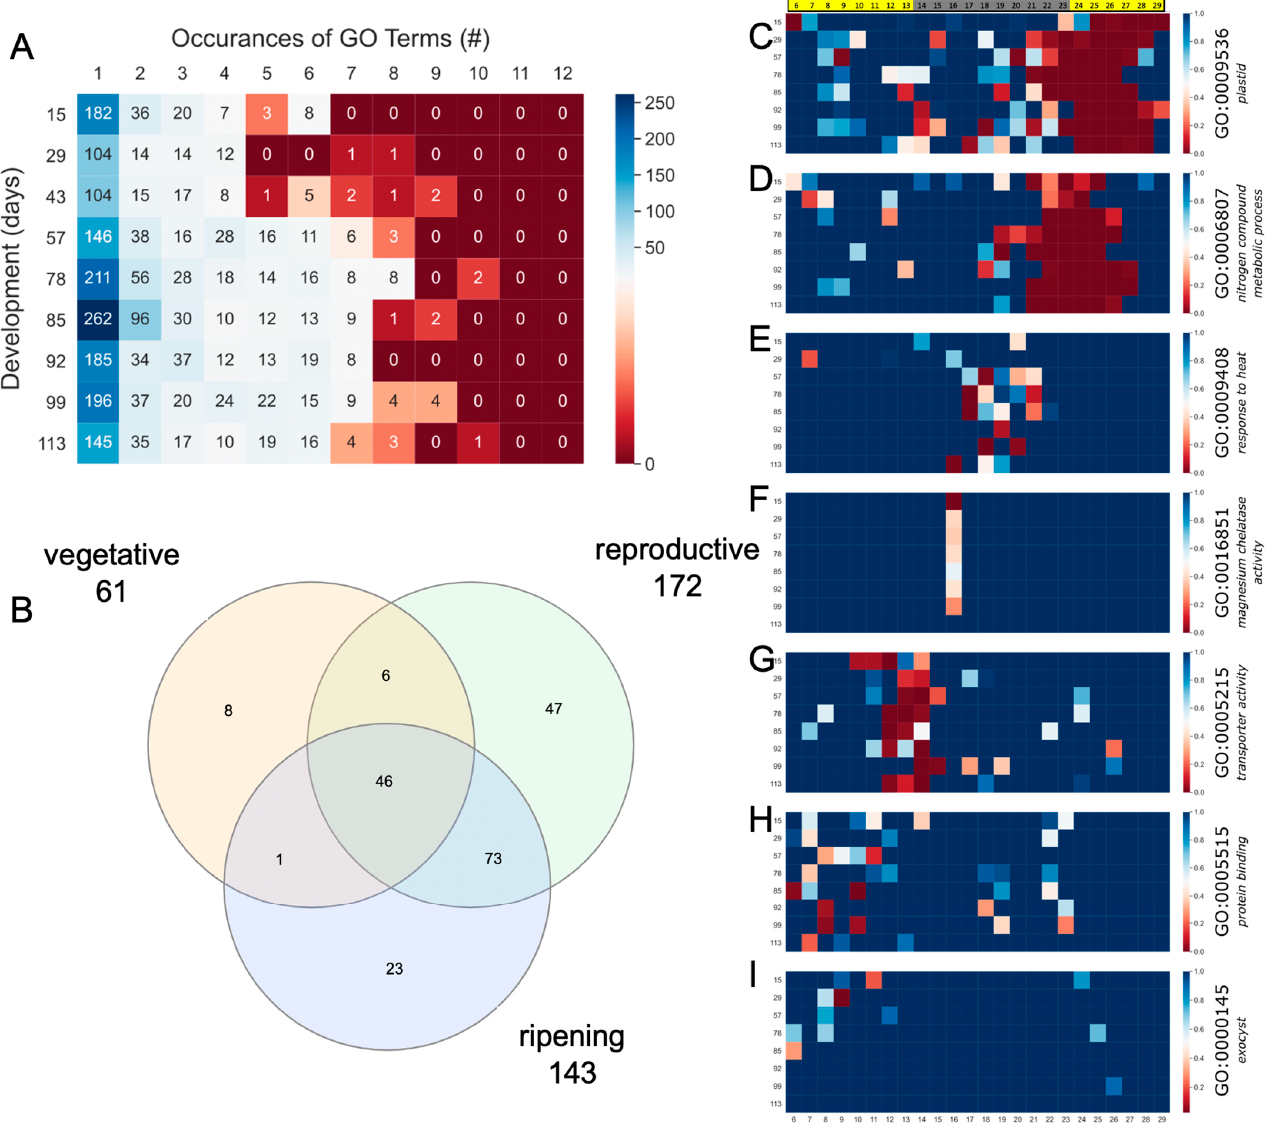
Figure 5. Gene ontology (GO) terms across the developmental time course. ( A ) Summary of the number of significant ( p < 0.05) across the developmental time course and the number of times they are significant across each time course; ( B ) overlap of the GO terms across the vegetative, reproduc- tive and ripening phases reveals 46 terms that are shared; significance plotted by TOD across the developmental time course for: ( C ) plastid (GO:0009532); ( D ) nitrogen compound metabolic process (GO:0006807); ( E ) response to heat (GO:0009408); ( F ) magnesium chelatase activity (GO:0016851); ( G ) transporter activity (GO:0005215); ( H ) protein binding (GO:0005515); ( I ) exocyst (GO:0000145). Green, more significant; red, less significant/non-significant.